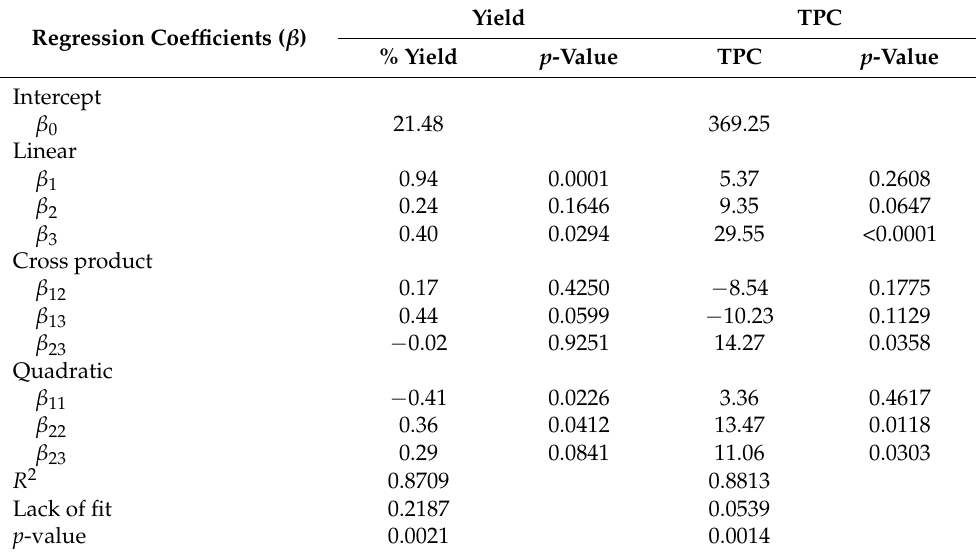
Table 3. The regression coefficients of the second-order polynomial models of the predicted for yield and total phenolic contents (TPC) of